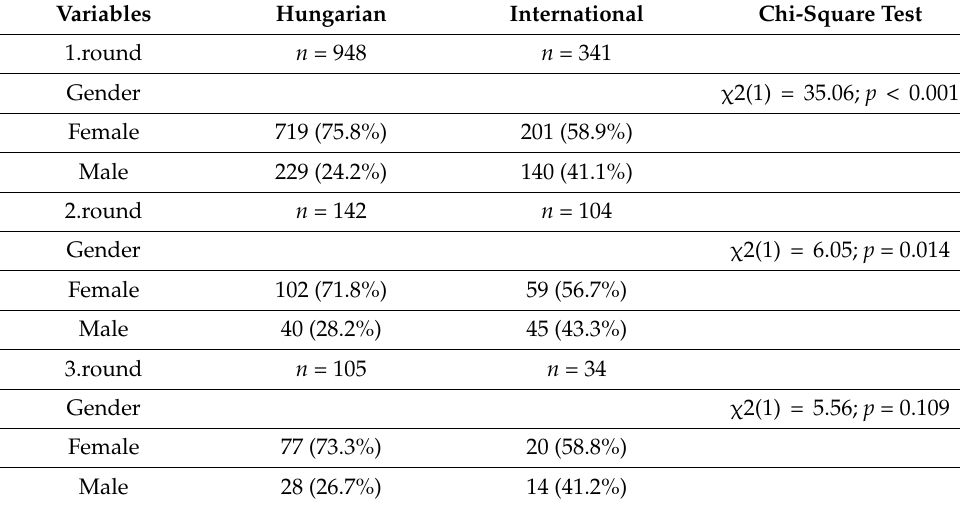
Table 1. Demographic characteristics of the